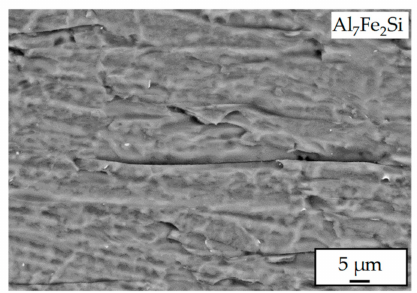
Figure 7. Fracture surface of the sample aged at 500 ◦ C for 6 h after the tensile shear